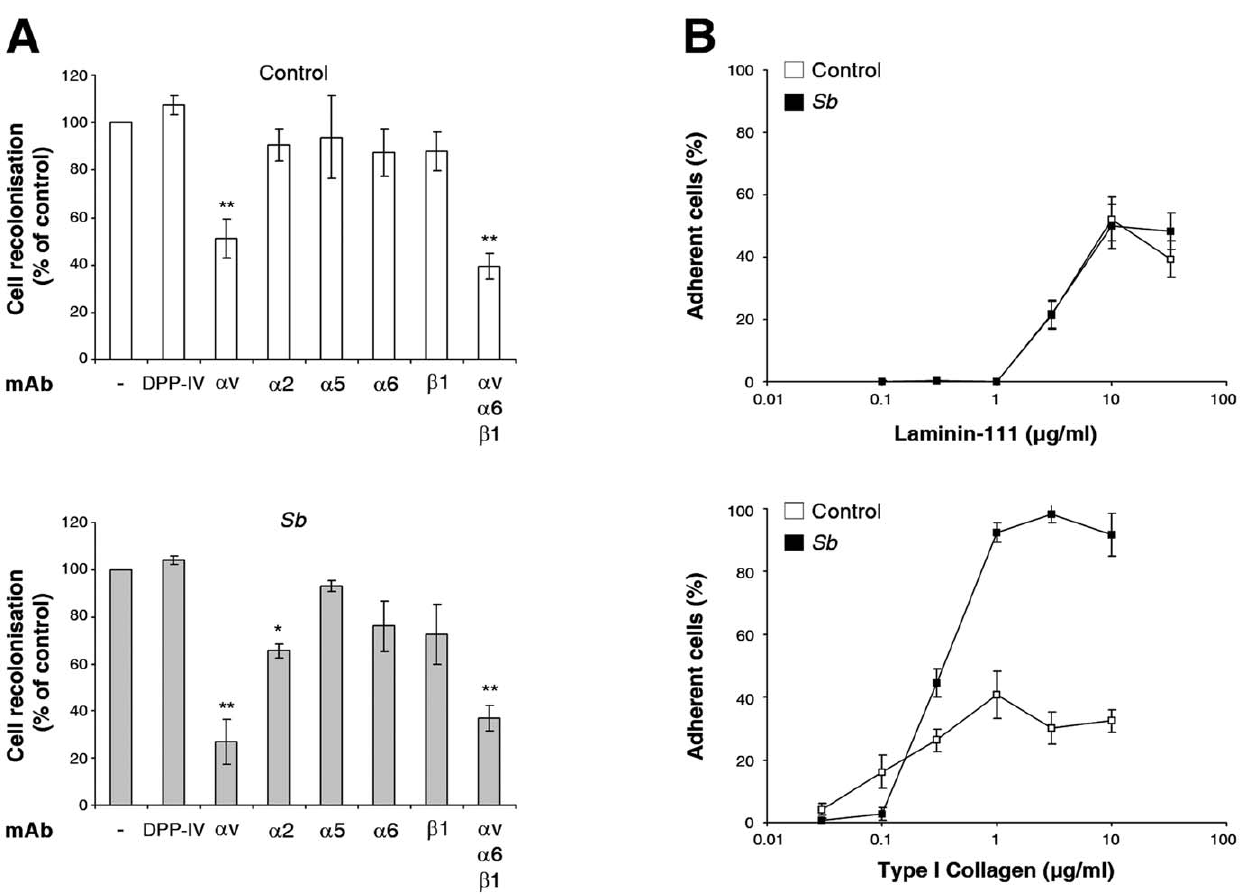
Figure 6. Sb -stimulated cell restitution requires modulation of the interaction between a 2 b 1 integrin and collagen. ( A ) HCT-8/E11 cell monolayers were wounded and incubated with or without Sb supernatant. The monolayers were further incubated with or without ( 2 ) function- blocking anti-integrin mAbs (10 m g/mL) 1 hour before wounding and during cell migration. Wound closure was determined as described in Methods. Results are expressed as the percentage of cell migration compared to control. Data represent the mean 6 SD of 5 separate experiments. ** P , .01; * P , .05. A mouse anti-DPP IV (DPPIV) mAb was used as a control for anti-integrin mAb specificity. ( B ) Isolated HCT-8/E11 cells were treated with or without Sb supernatant and plated on either laminin-111 or type I collagen at the indicated concentrations. Cell-ECM adhesion was evaluated as described in Methods. Results are expressed as the percentage of cell adhesion. Data represent the mean 6 SD of 3 separate experiments.